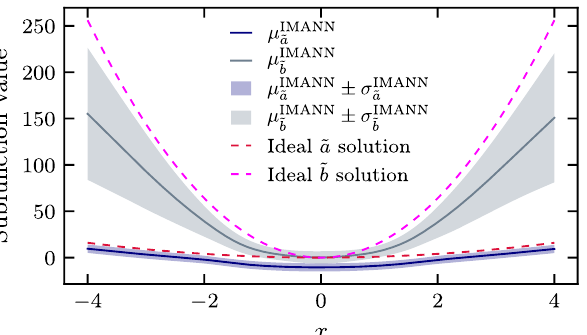
Figure 10. Mean predictions µ ˜ a and µ ˜ standard deviation σ ˜ a and σ ˜